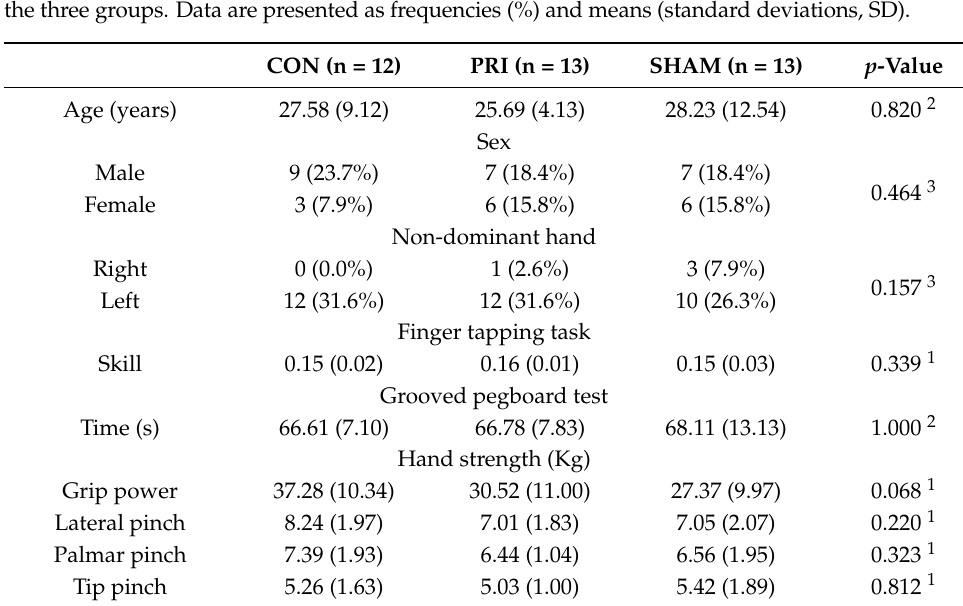
Table 1. Comparison of the baseline demographic characteristics and motor task performance between the three groups. Data are presented as frequencies (%) and means (standard deviations,